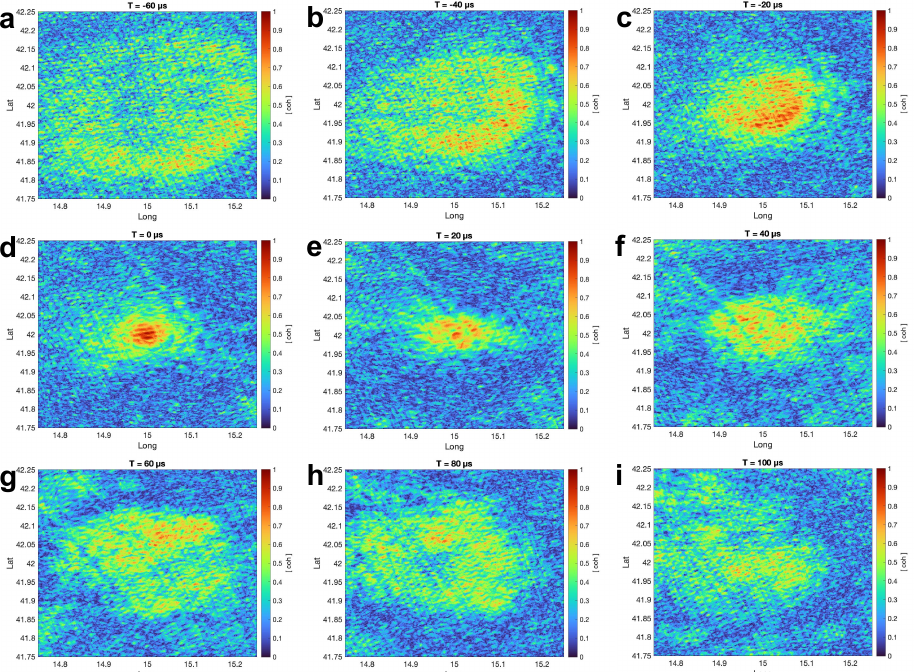
Figure 12. The coherency maps with a small receiver network with a simulated lightning location of 15°E and 42°S ( N = 20). Each sub-figure ( a – i ) is the coherency map at a different time. The amplitude waveforms of small receiver networks are shown in Figure 13a,b with 10 and 20 receivers, respectively. The corresponding scaled amplitude maps are shown in Figures 14 and 15. It can be seen that the scaled waveforms are similar to the